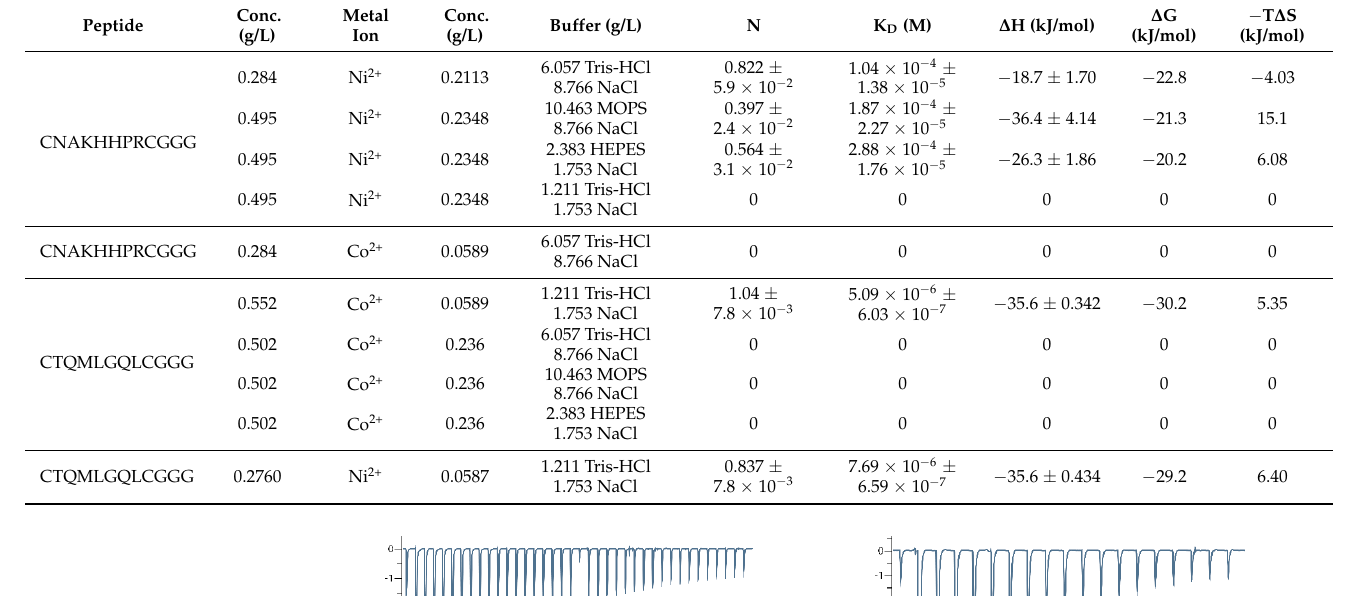
Table 1. Thermodynamic parameters of complex formation of Ni 2+ specific binding cyclic peptide CNAKHHPRCGGG and Co 2+ -binding cyclic peptide CTQMLGQLCGGG with the respective metal ion and vice versa. All buffers had a pH of 7.4.